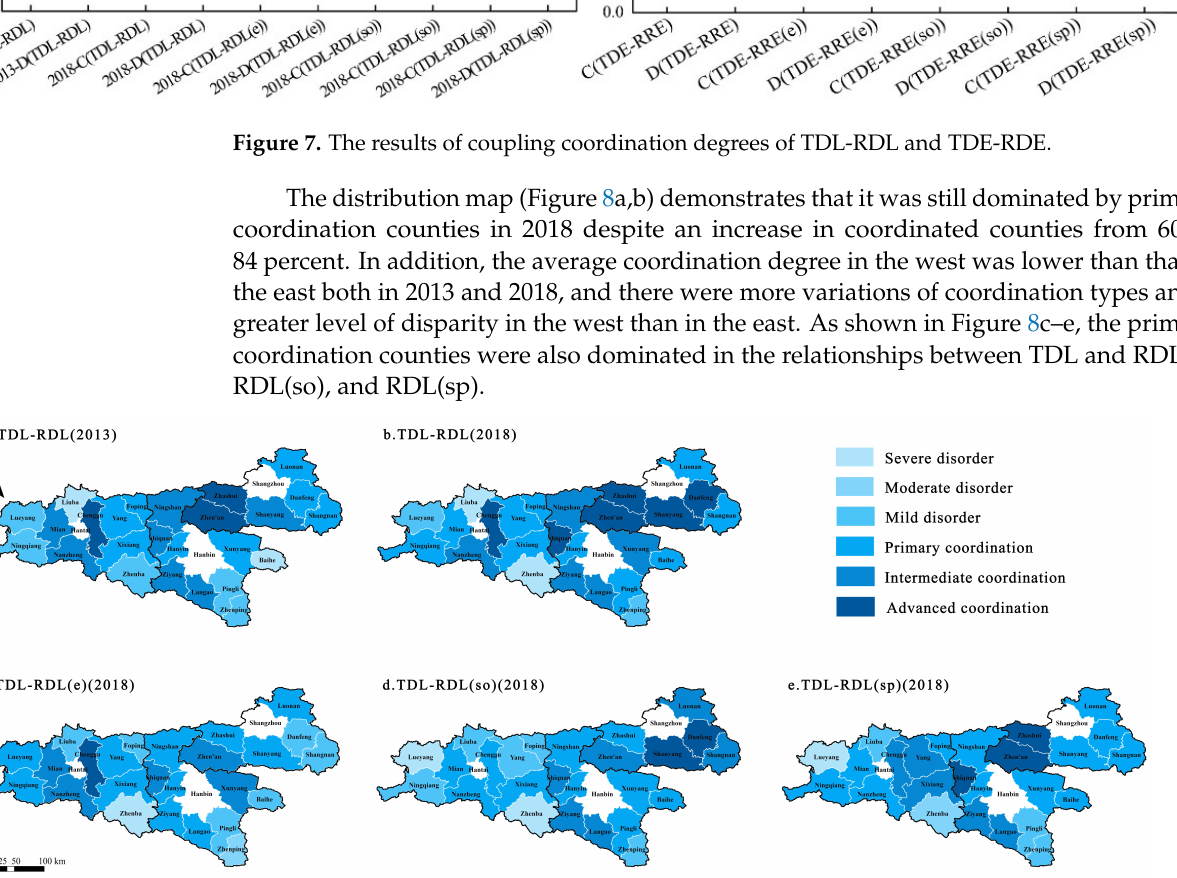
Figure 8. Distribution map of coordinating types between TDL and RDL, RDL(e), RDL(so),